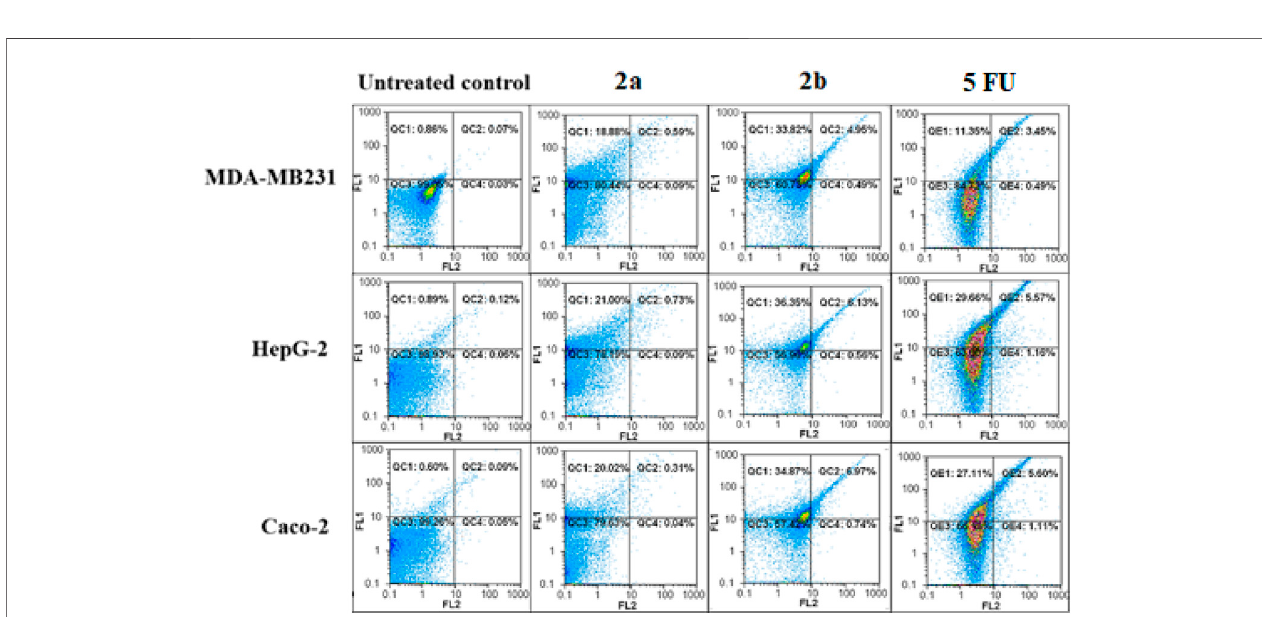
FIGURE11| Flowcharts ofannexin-PI analysisof 2a- and 2b -treated MDA-MB 231, HepG-2, and Caco-2cells compared with5- fl uorouracil (5-FU)-treatedcells.